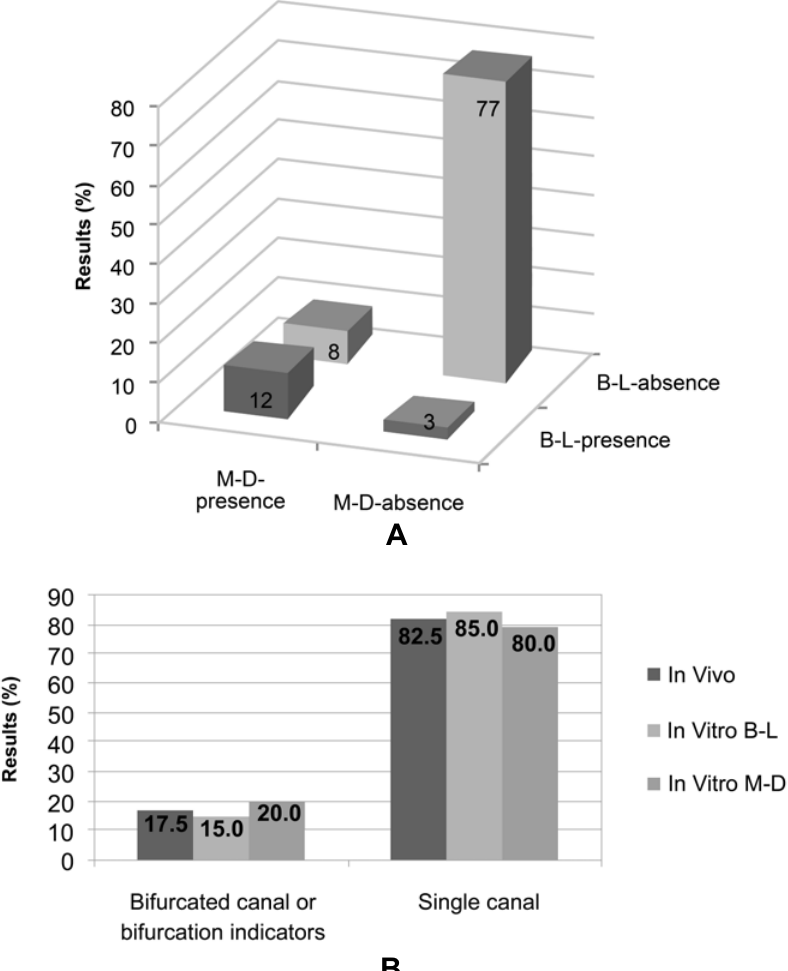
FIGURE 7- A- Graphic presentation demonstrating the comparison between the percent results of mandibular central and lateral incisors in the in vitro study. B- Graphic presentation demonstrating the percent correlation between in vitro and in vivo